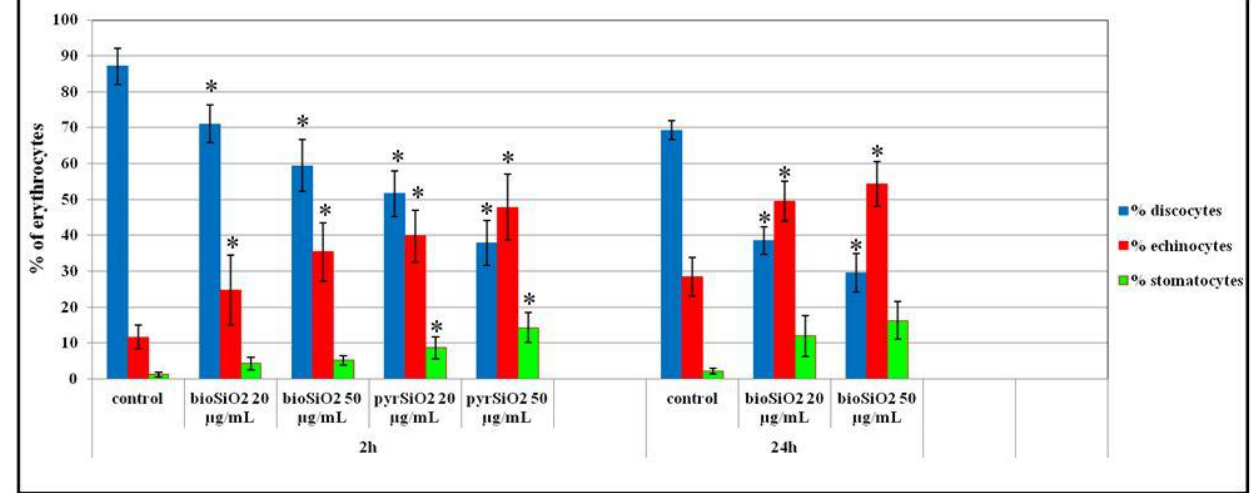
Figure 13. The microscopic studies of erythrocytes shapes. The results prove that SiO 2 nanoparticles are responsible for changes in the shape of erythrocytes after 2 h and 24 h of exposure. Statistical evaluation of differences was made using the ANOVA I and Tukey’s post hoc test, at significance levels of p < 0.01 (*) with respect to control.